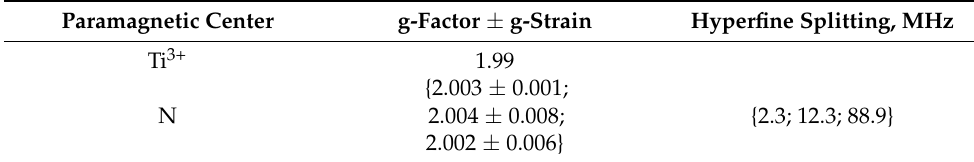
Table 2. Parameters of individual components in EPR spectra.